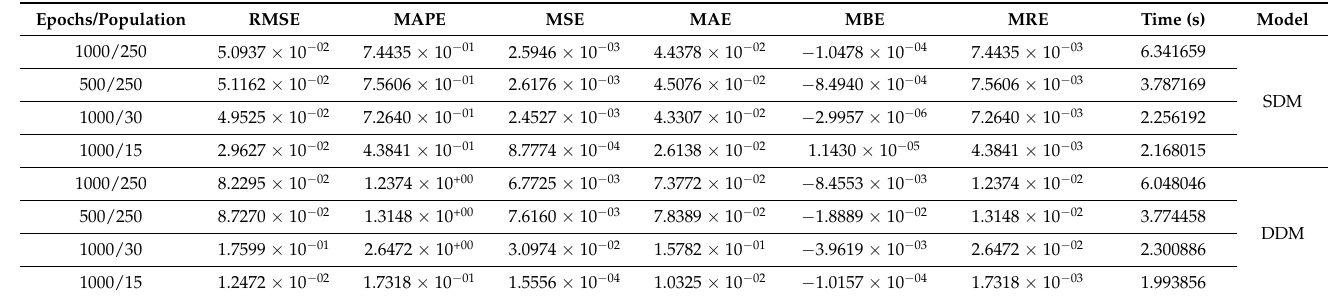
Table 26. Influence of the epochs and population on the statistical tests, Sharp ND-R250A5 photo- voltaic panel.